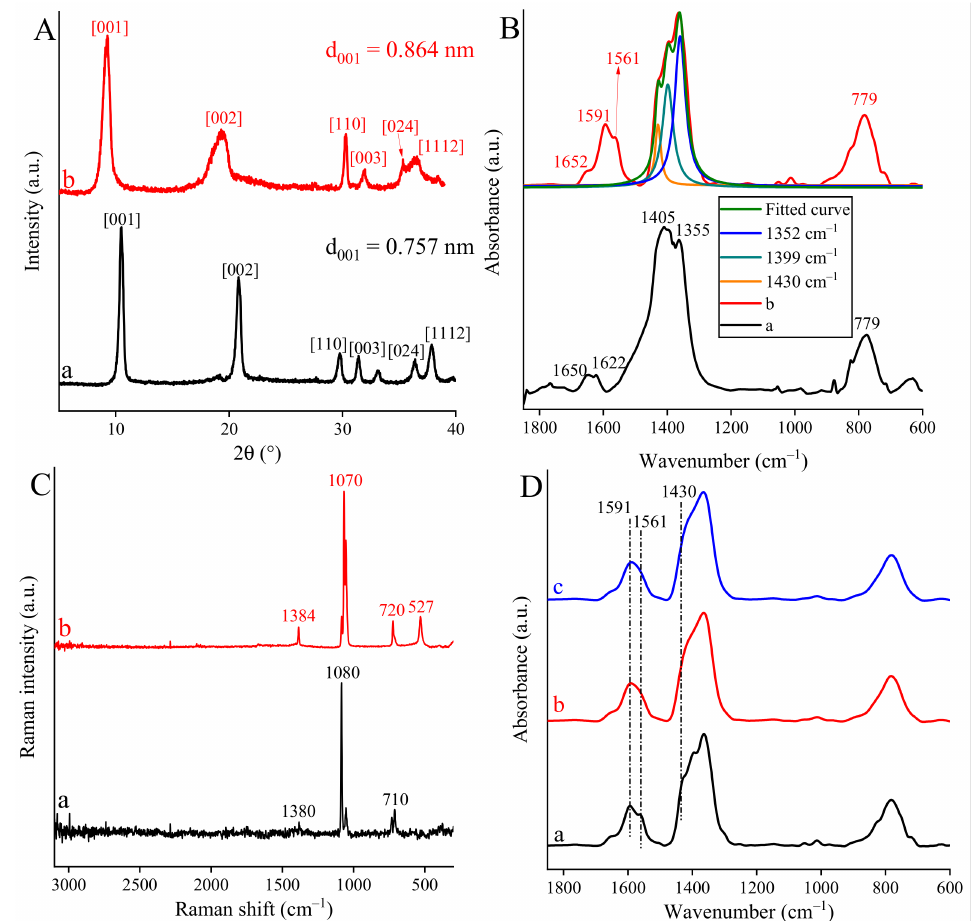
Figure 1. X-ray diffraction (XRD) patterns ( A ), IR ( B ) and Raman ( C ) spectra of CaAl–NO 3– –LDH (a) and CaAl–cysteinate–LDH (b). IR spectra ( D ) of CaAl–cysteinate–LDH (0.1 g) using 6.0 × 10 − 3 mol (a), 1.2 × 10 − 2 mol (b) or 1.8 × 10 − 2 mol (c)